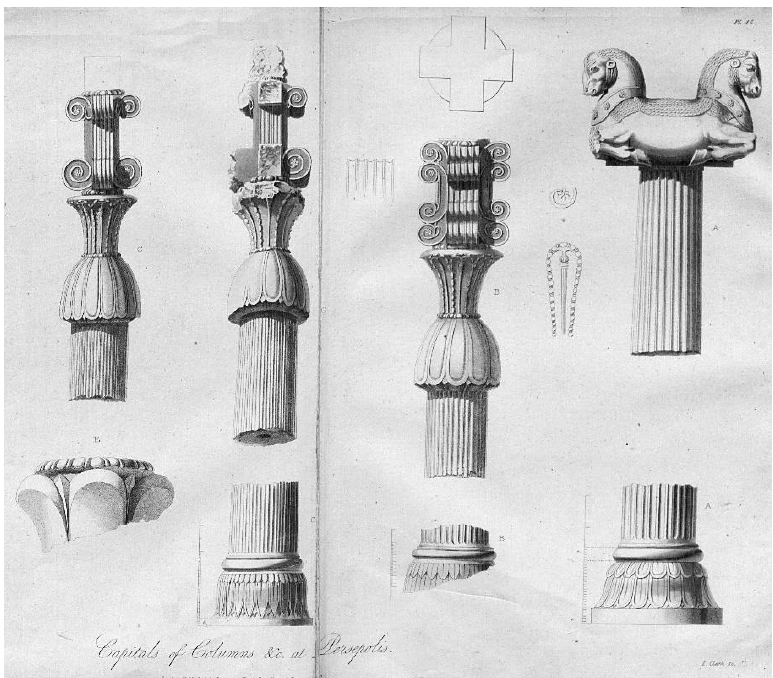
Figure 7. Porter’s drawings from the Columns of Persepolis. The second one from right hand is Porter’s illustration from the columns of the Gate [33] (PL. XLV). Source: Staatsbibliothek zu Berlin.